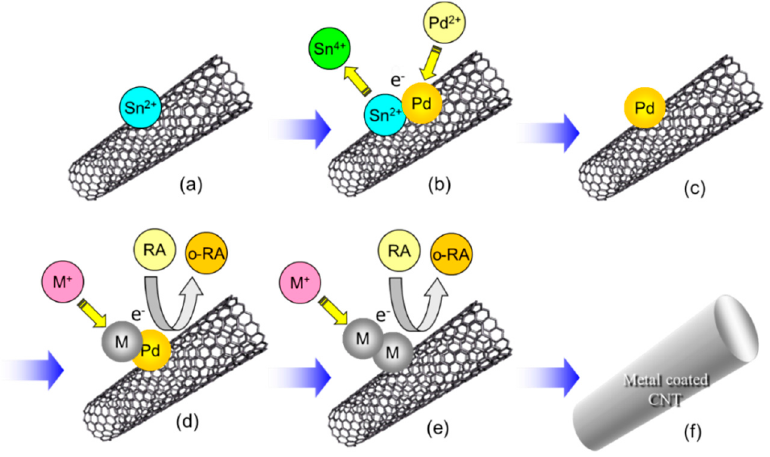
Figure 13. A fabrication process of metal-coated CNTs by electroless deposition. ( a ) adsorption of Sn 2+ on CNT, ( b ) Redox reaction: Sn 2+ to Sn 4+ and Pd 2+ to Pd, ( c ) Pd catalyst nanoparticle on CNT, ( d ) Redox reaction on the Pd catalyst particle: reducing agent (RA) to oxidized reducing agent (o-RA) and metal ion (M + ) to metal (M), ( e ) redox reaction in ( d ) continues even on the deposited M catalytically, ( f ) CNT is coated entirely with M, results in metal-coated CNT. The processes of ( a – c ) are pre-treatment processes and those of ( d – f ) are electroless deposition processes.